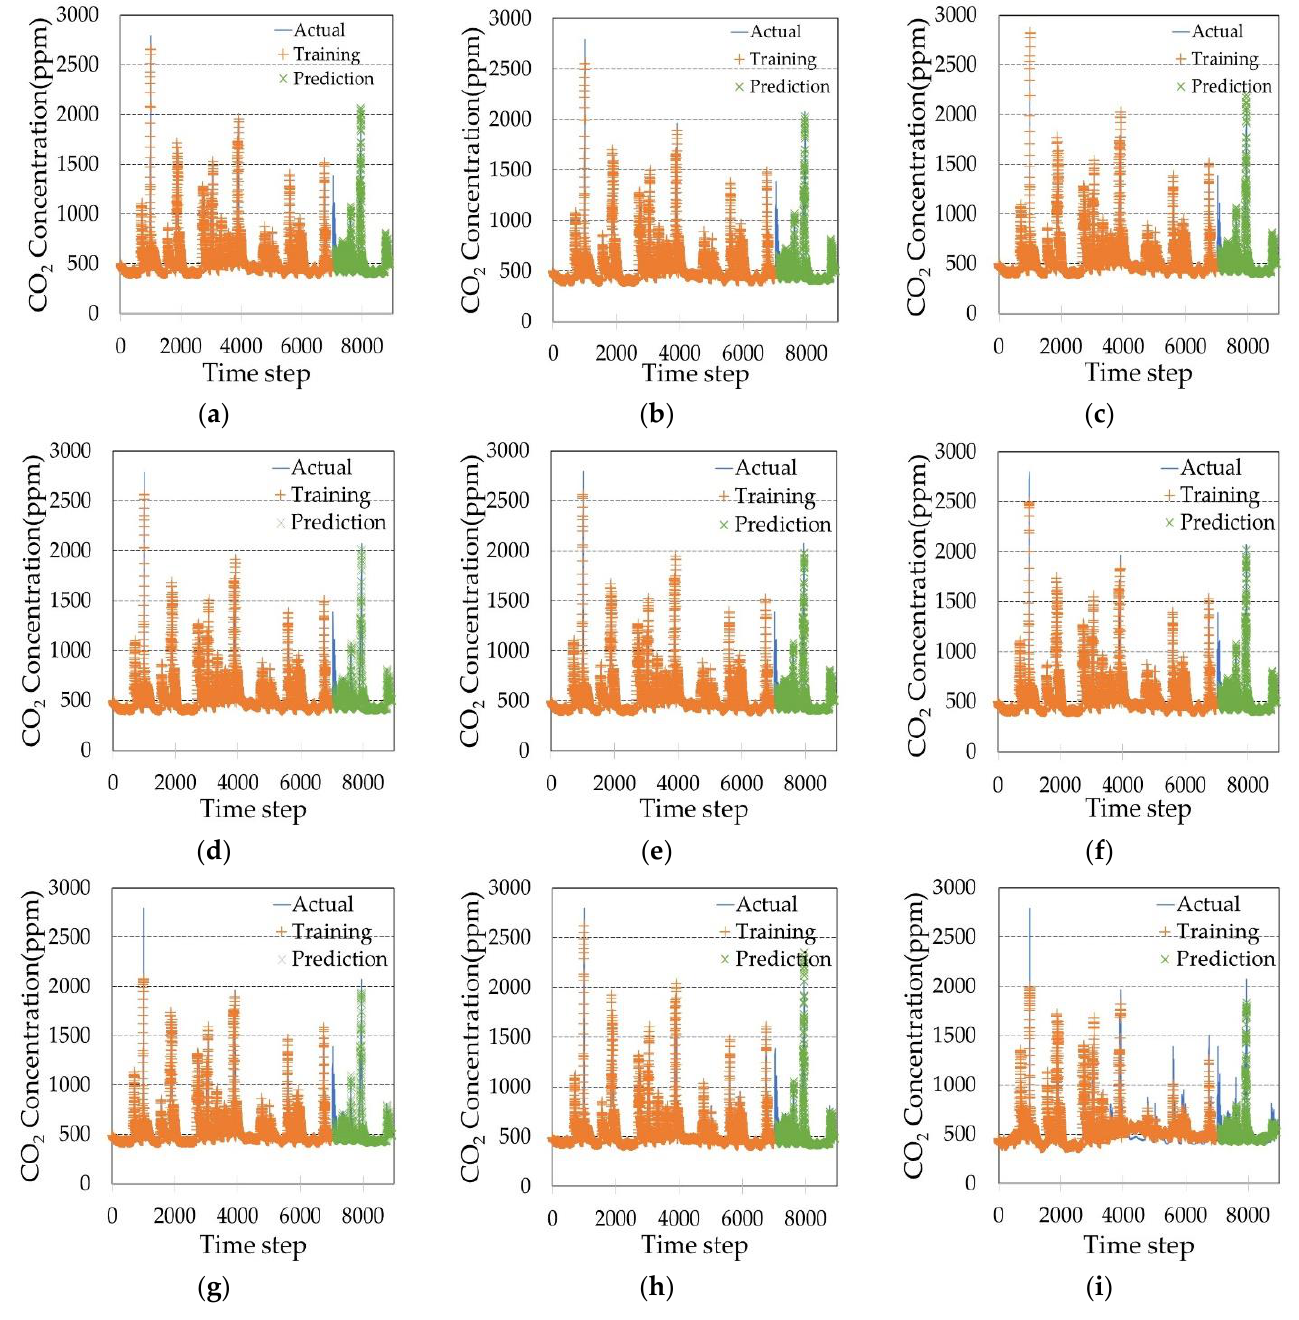
Figure 3. Prediction results of CO 2 concentration.( a ) LM-Hidden layer-1; ( b ) LM-Hidden layer-3; ( c ) LM-Hidden layer-5; ( d ) BR-Hidden layer-1; ( e ) BR-Hidden layer-3; ( f ) BR-Hidden layer-5; ( g ) BFG-Hidden layer-1; ( h ) BFG-Hidden layer-3; ( i ) BFG-Hidden layer-5.